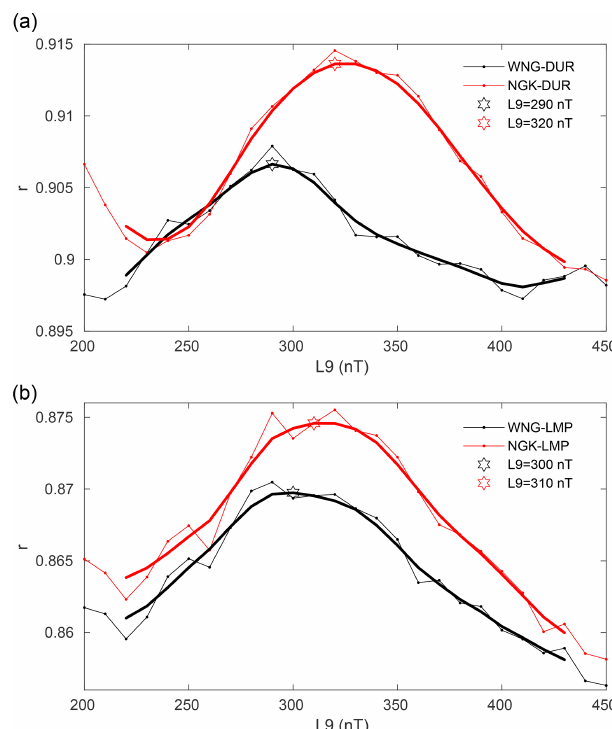
Figure 4. Correlation analyses between the K index at NGK and that computed at DUR (a) and LMP (b) by KASM for different L9 values for the 2017–2018 dataset. The thick lines are obtained by smoothing the experimental (thin) lines. In each panel the maximum correlations, referring to the thick lines, are marked by stars (see the text for